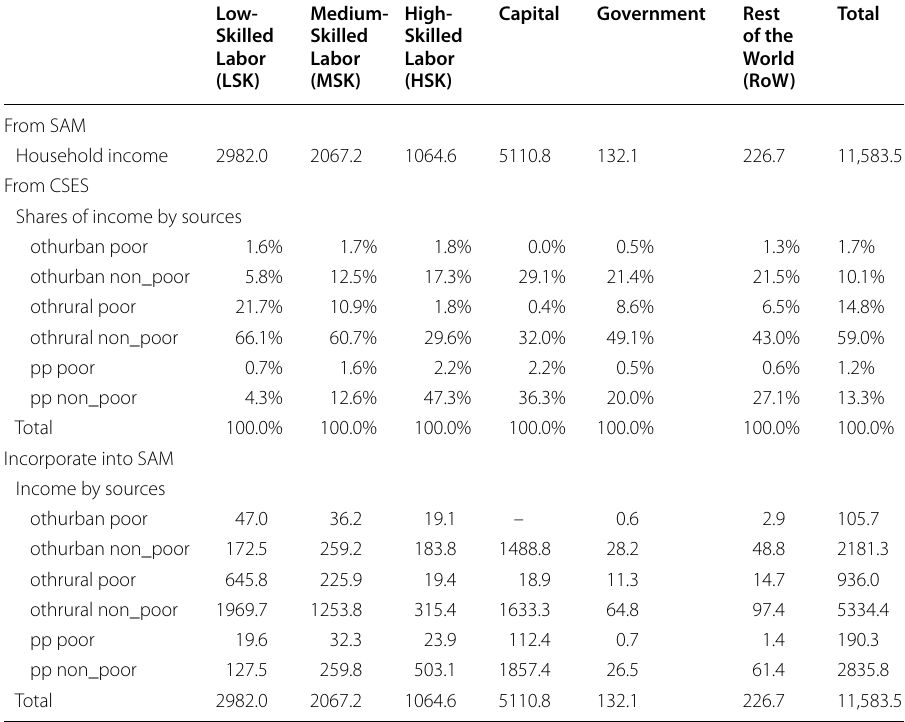
Table 6 Estimation of household income in the SAM. Source : Author’s calculation based on CSES (2009) and SAM